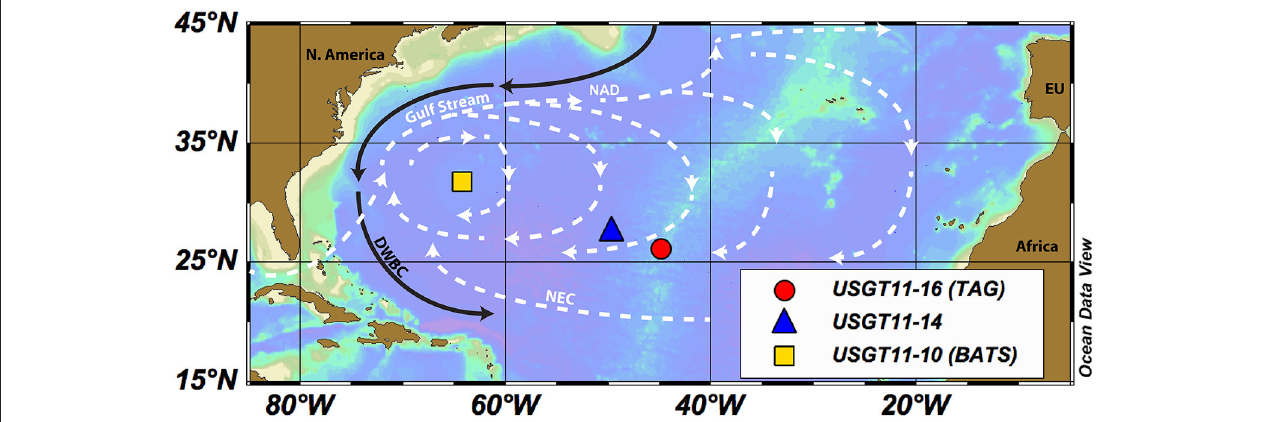
FIGURE 1 | Study area with sampled locations USGT11-10 (BATS, yellow square), USGT11-14 (blue triangle), and USGT11-16 (TAG, red circle). Major currents of the North Atlantic Gyre are illustrated as surface currents in dashed white lines (Gulf Stream, North Atlantic Drift, NAD and North Equatorial Current, NEC) and the Deep Western Boundary Current (DWBC, black line). The figure is designed with ODV ® software ( Schlitzer,